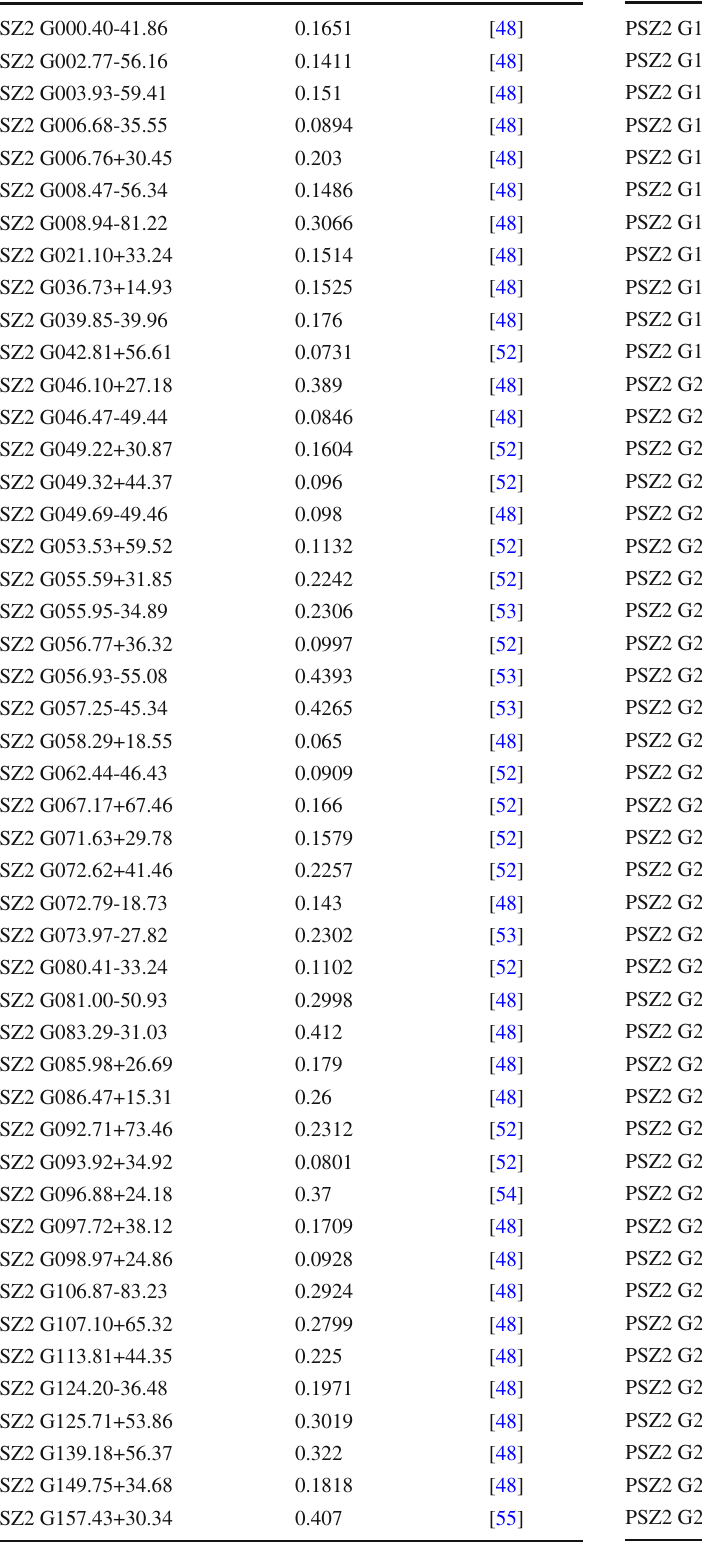
Table 1 Redshifts of Planck-ESZ clusters used for this analysis